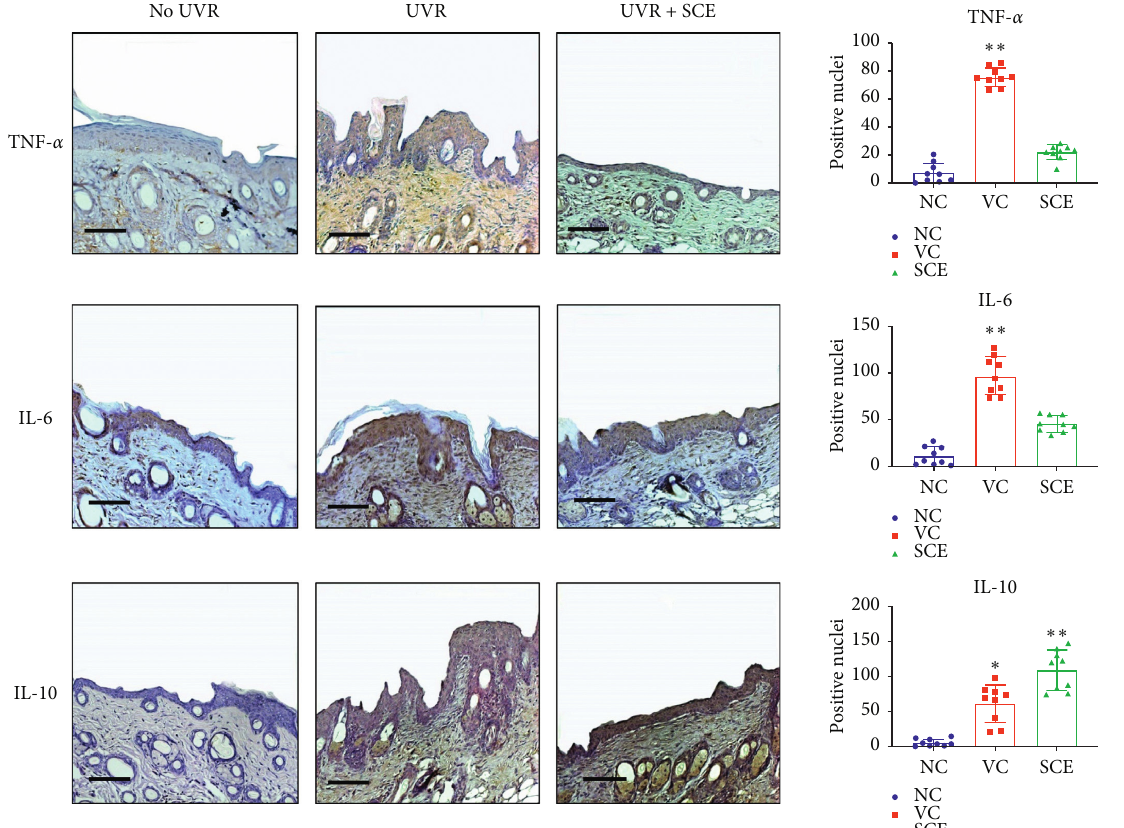
Figure 5: Immunohistochemistry analyses of target proteins TNF- α , IL-6, and IL-10. Scale: 50 um. ∗∗ Highly significantly different compared to control (NC); P < 0 .